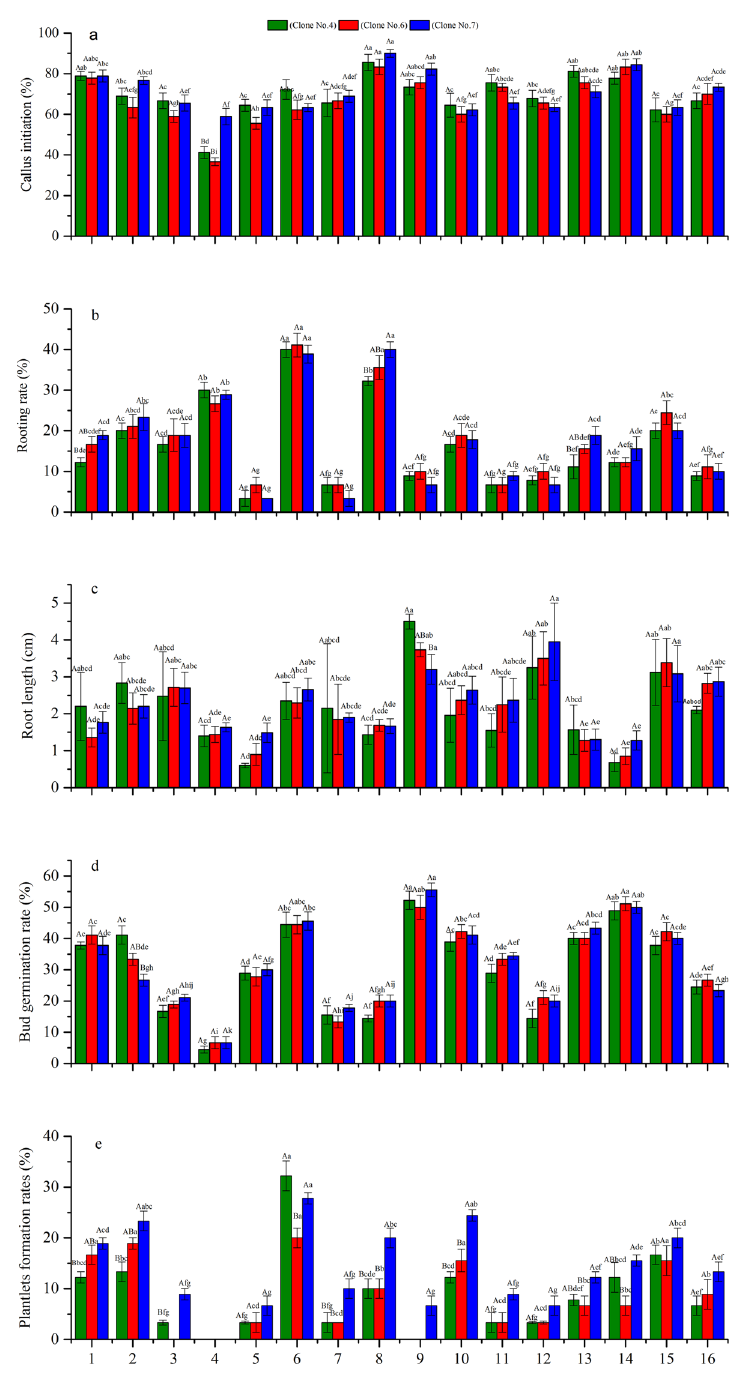
Figure 2. Effects of different hormone combinations of leaf cuttings taken from Chinese fir clones. Treatment numbers 1–16 are shown on the x-axis, and values for the three different clones are represented by the three different colored columns. ( a ) Callus initiation rates; ( b ) rooting rates; ( c ) root length; ( d ) bud germination rates; ( e ) plantlet formation rates. Different lowercase letters above the columns indicate significant difference between treatments for the same clone ( p < 0.05). Different capital letters indicate significant difference between clones under the same treatment ( p < 0.05). Values are means and the error bars represent standard